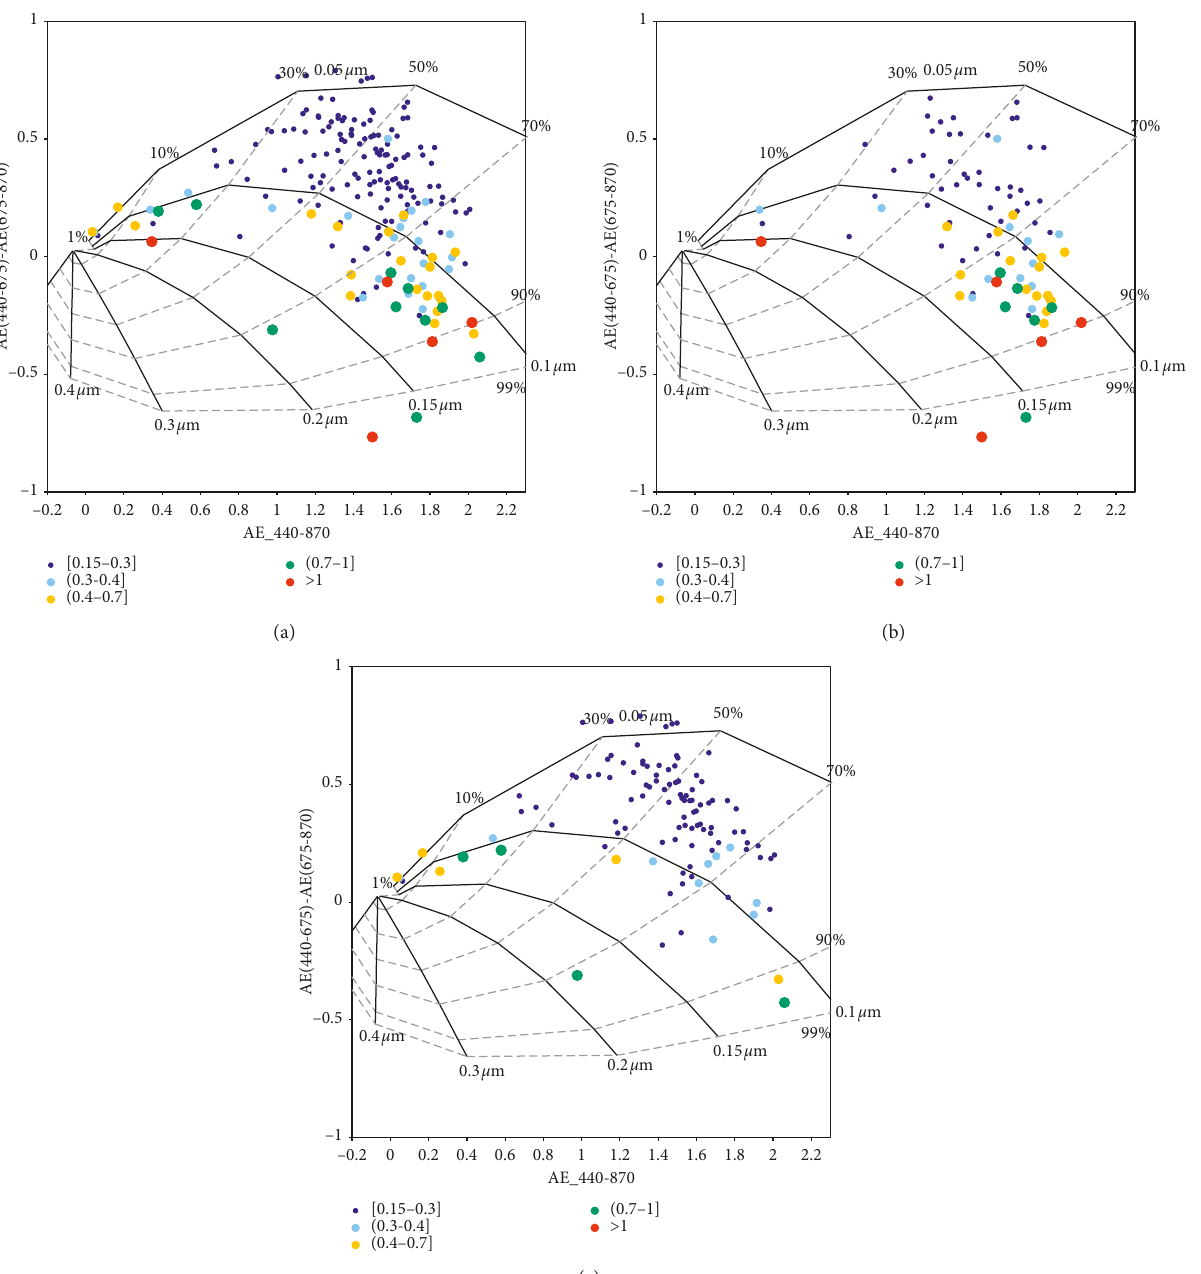
Figure 6: ˚Angstr¨om exponent difference as a function of the ˚Angstr¨om exponent and AOD (colour code) for CEILAP-BA. Only data with AOD500nm greater than 0.15 are included: (a) all days in the selected period (2001–2005); (b) all days during the biomass-burning months; and (c) all days in no-burning